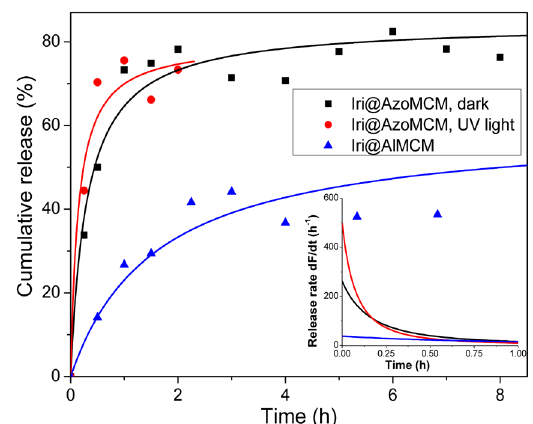
Figure 9. Cumulative irinotecan release versus time from Iri@ AzoMCM in dark conditions and under UV irradiation and from Iri@AlMCM with experimental data presented as symbols and fitted hyperbolic function F(t) presented as a continuous line. The inset shows the drug release rate dF/dt versus time for the first hour of release, computed numerically as dF / dt